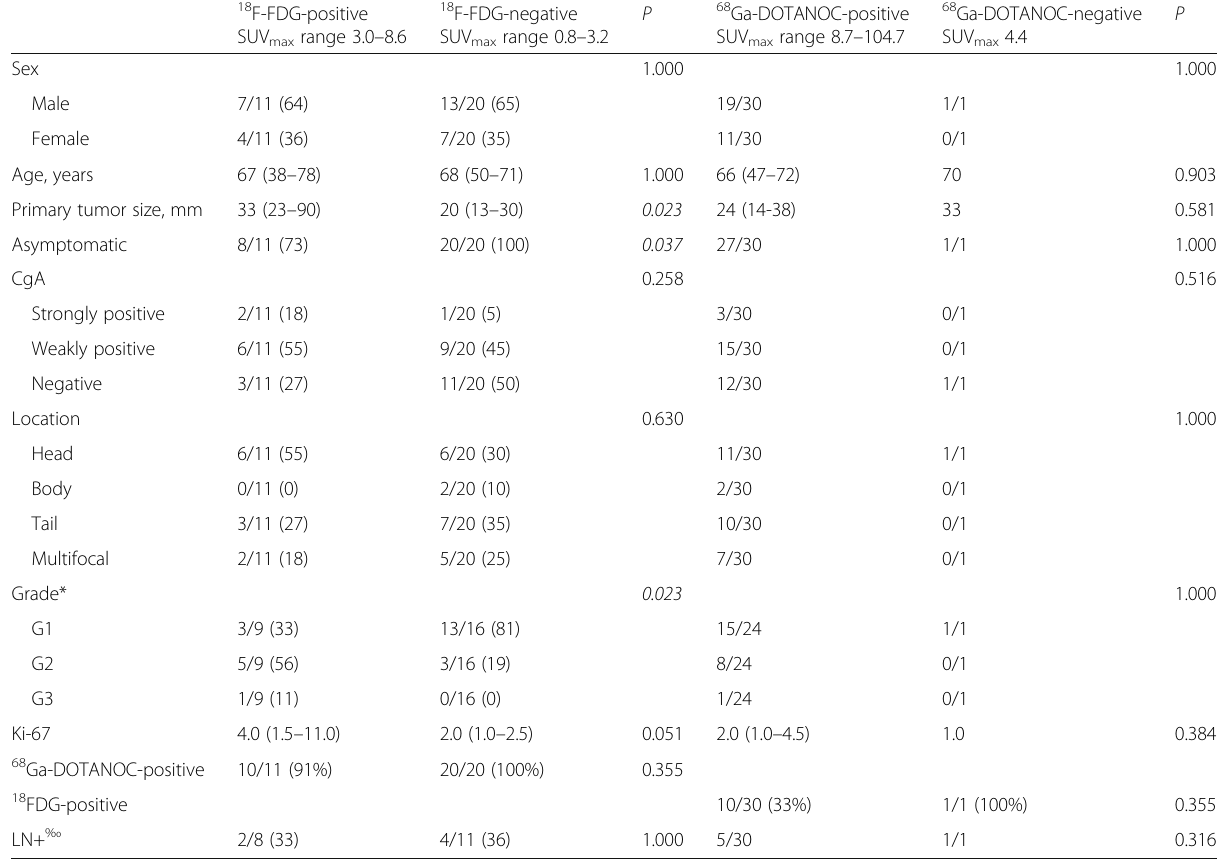
Table 3 Clinical, histopathological and metabolic features of NF-PNETs 18